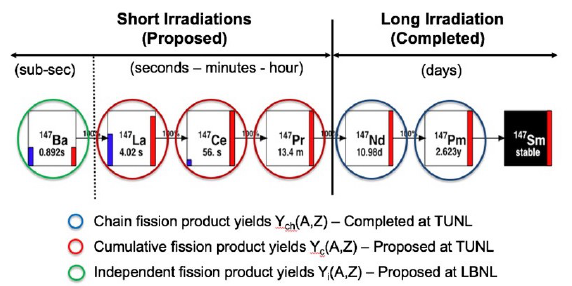
Figure 1. Example decay chain illustrating the complementary information one obtains by varying the lengths of irradiations in order to measure di ff erent isotopes with di ff erent